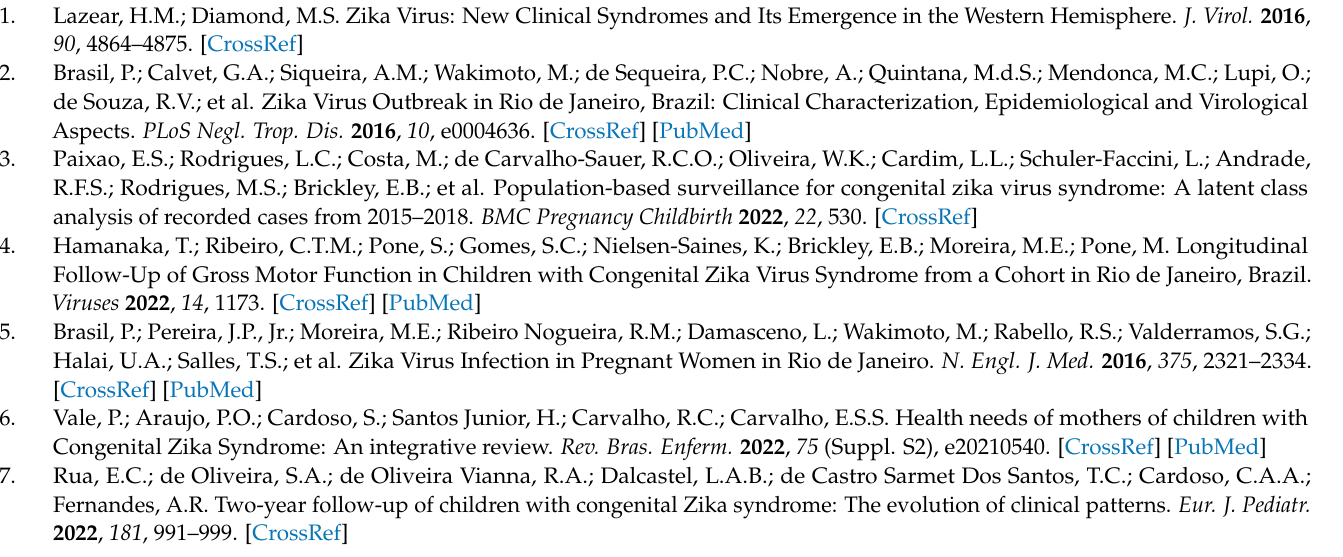
Figure S2. Upregulation of cell surface expression of Tyro3 and AXL of the trophoblast Swan.71 cells upon the TGF- β 1 treatment via the Smad pathway; Figure S3. Representative images of FCM analysis of the virus binding assay with double staining of ZIKV and Tyro3 or